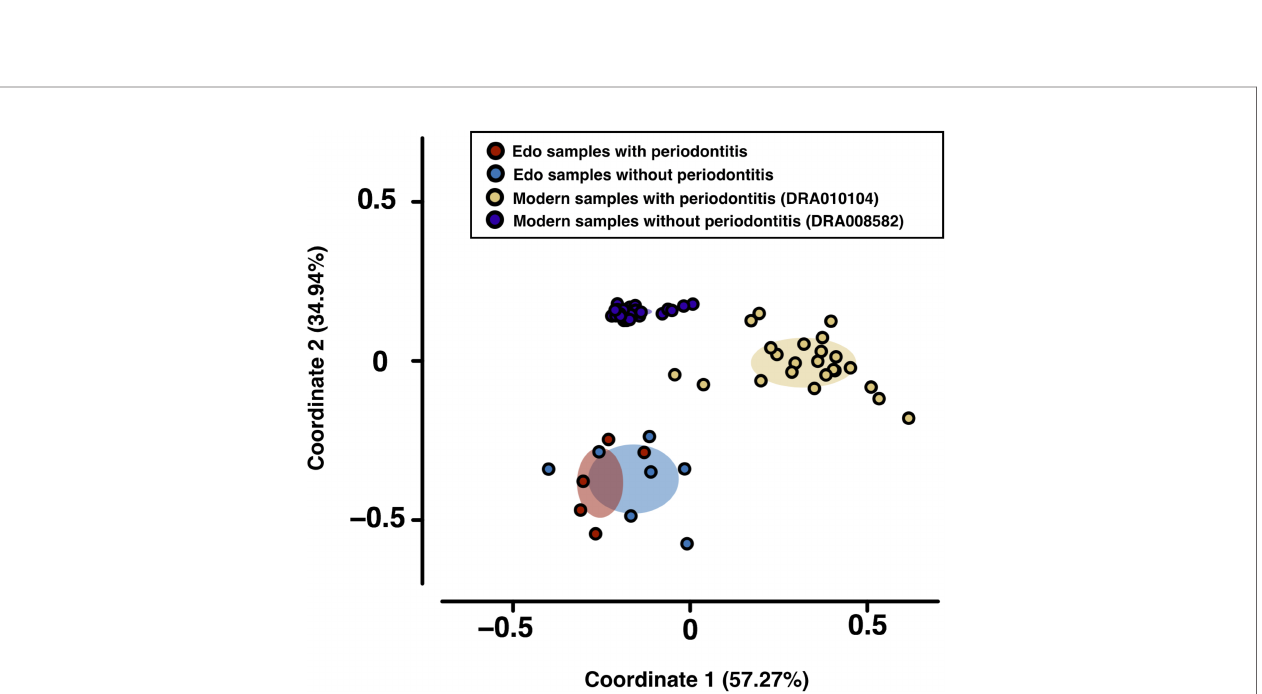
FIGURE 4 | Principal coordinate analysis (PCoA) was conducted for the dissimilarity matrix value of 1 — Spearman ’ s coef fi cient. PCoA was used to evaluate bacterial similarity for comparison between Edo and modern microbiomes according to